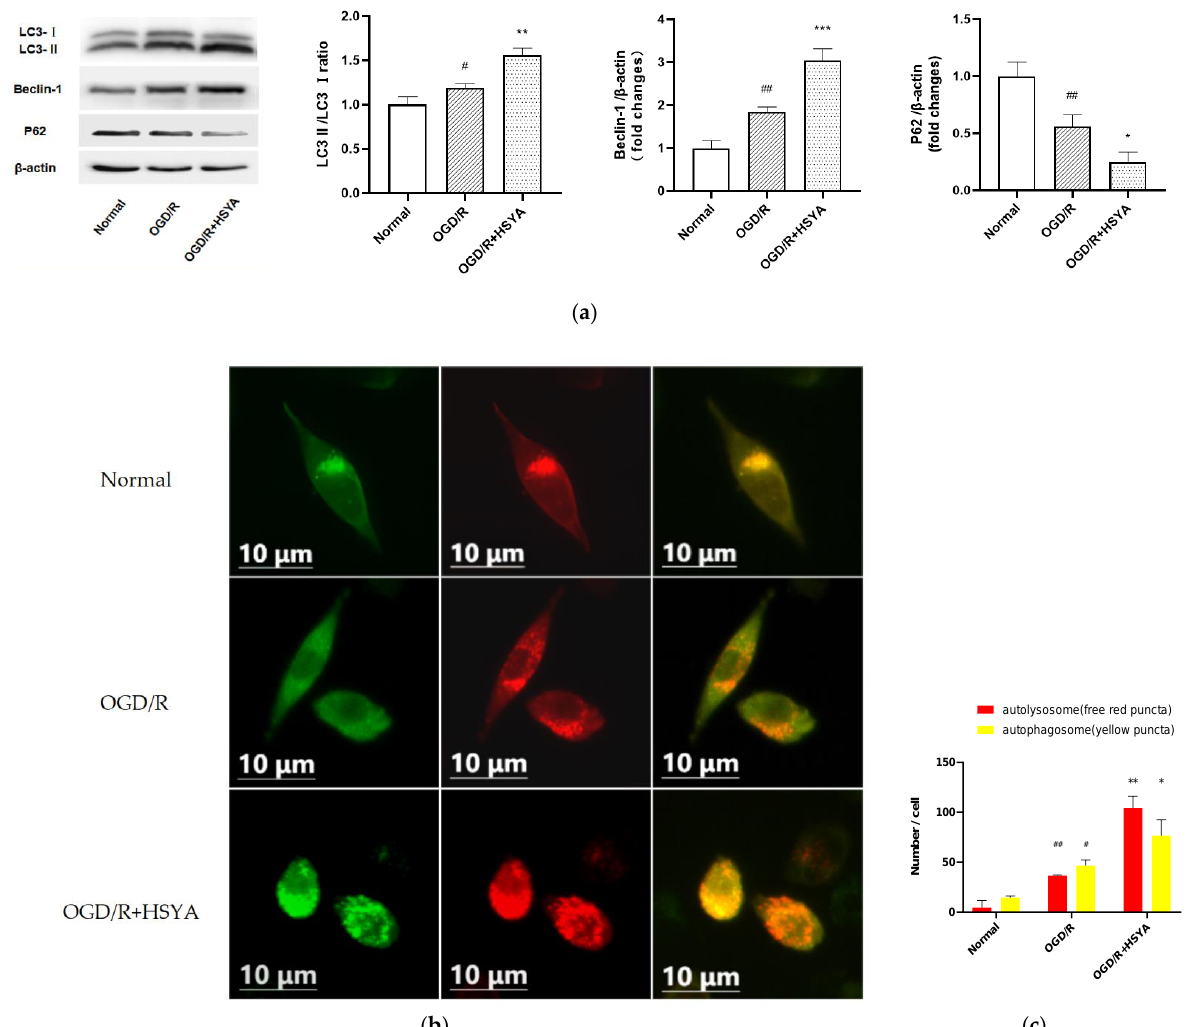
Figure 5. HSYA activates autophagy and maintains a stable autophagic flux in SH-SY5Y cells during the acute phase of OGD/R injury. ( a ) Western blotting for the levels of LC3, Beclin-1, and p62 in SH-SY5Y cells treated with indicated conditions. ( b ) Changes in autophagic flux of HSYA on OGD/R-treated SH-SY5Y cells. Fluorescence microscopy analysis of SH-SY5Y cells transfected with mCherry-GFP-LC3B; the image shown is one of the representative results for each group. ( c ) Statistical analysis of fluorescent dots in SH-SY5Y cells. Yellow dots indicate autophagosomes and red dots indicate autolysosomes in the merged images. Results are representative of three independent experiments, and the data were statistically analyzed using one-way ANOVA and expressed as mean ± standard deviation. (Note: compared with the normal group, ## p < 0.01, # p < 0.05; compared with the OGD/R group, *** p < 0.001,** p < 0.01, * p < 0.05.)